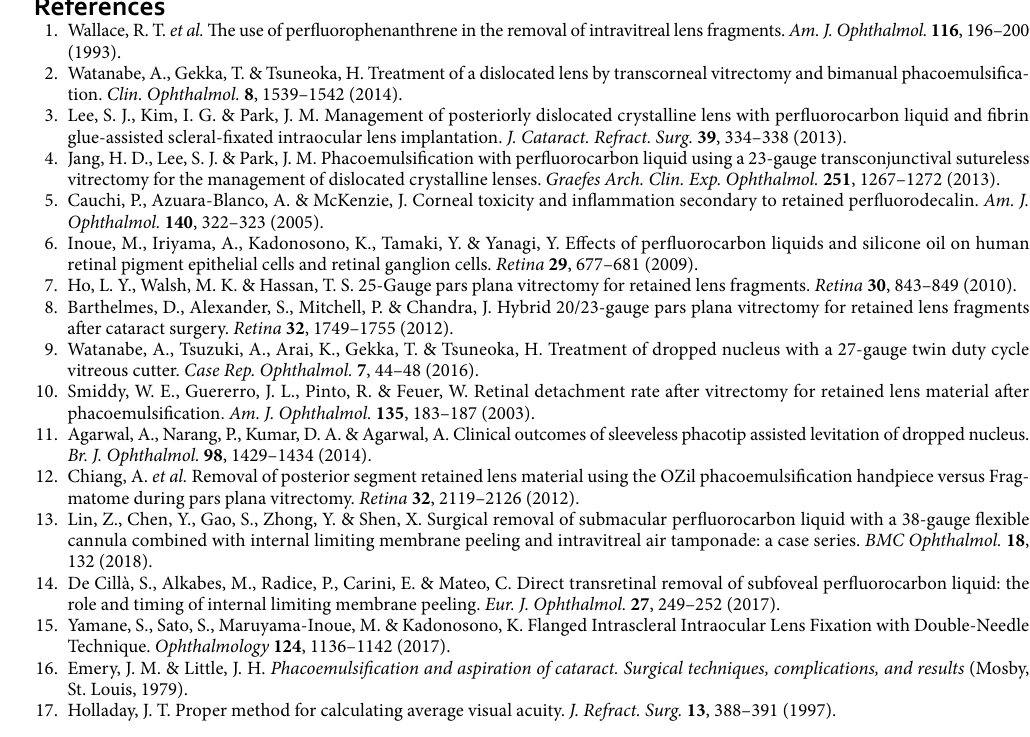
device. The incision was expanded to 2.8 mm before IOL insertion. In all cases, eyes were checked again at the end of the operation for the presence of retinal detachment or residual lens. Starting the day after surgery, topical 0.5% levofloxacin and 0.1% betamethasone eye drops were administered four times daily for one month and 0.1% bromfenac eye drops were administered twice daily for one month. We measured corneal endothelial cell density using Konan NSP 9900II specular microscopy (Konan Medical Inc., Nishinomiya, Japan) before and 1 month after surgery.